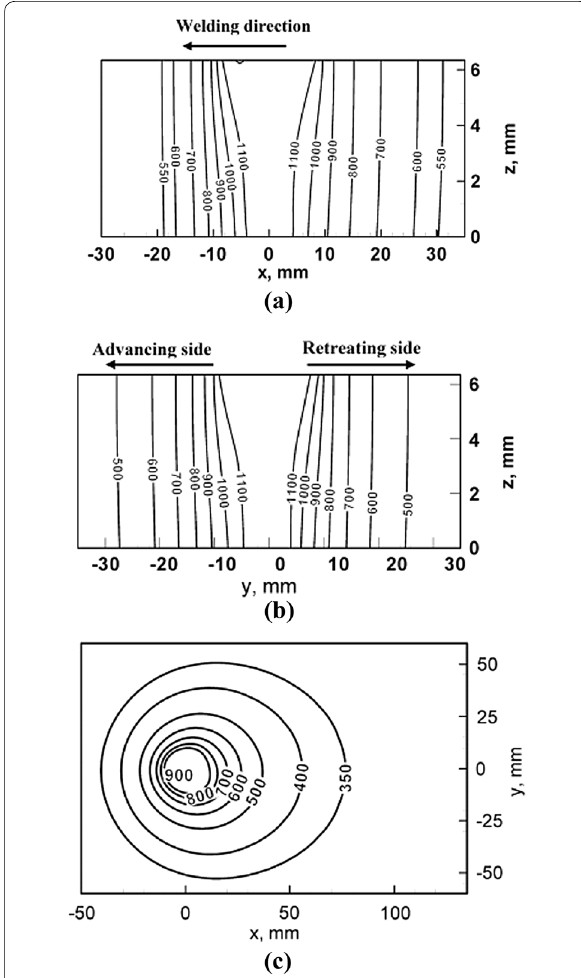
Figure 39 Temperature distributions at different sides of the welding: ( a ) at the X direction, ( b ) at the Y direction, ( c ) at the top section [84]